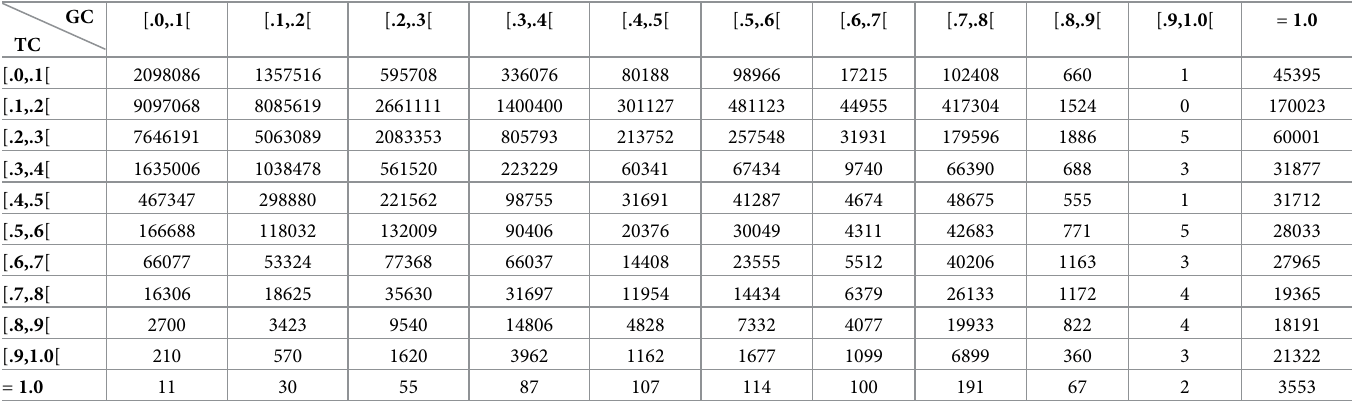
Table 4. Confusion matrix of TC Daylight and GC.